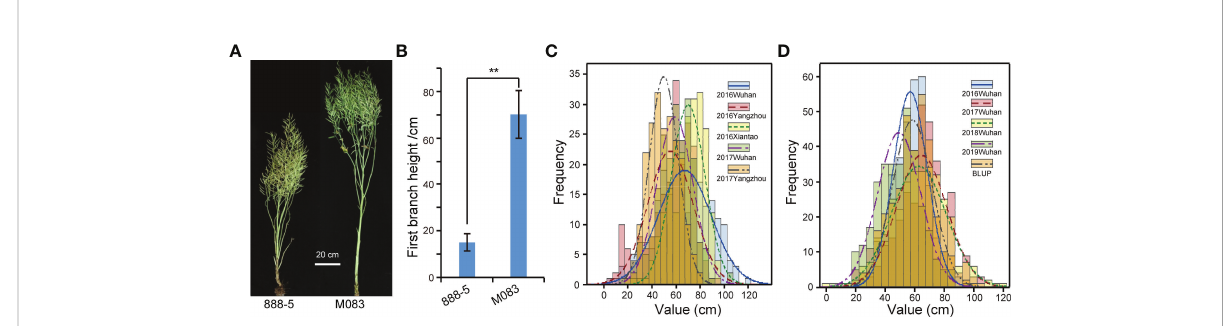
FIGURE 1 Parent phenotype and phenotypic frequency distribution of recombinant inbred lines (RILs) and natural accessions. (A) The mature stage phenotype of 888-5 and M083. Scale bar = 20 cm. (B) Comparison of fi rst branch height (FBH) between 888-5 and M083. Data are presented as means ± SD (n ˃ 20). The double asterisks represent a signi fi cant difference determined via Student ’ s t -test at P < 0.01. (C) FBH phenotypic frequency distribution in RILs under fi ve environments. (D) FBH phenotypic frequency distribution in 324 collected accessions under four consecutive years and best linear unbiased prediction (BLUP).